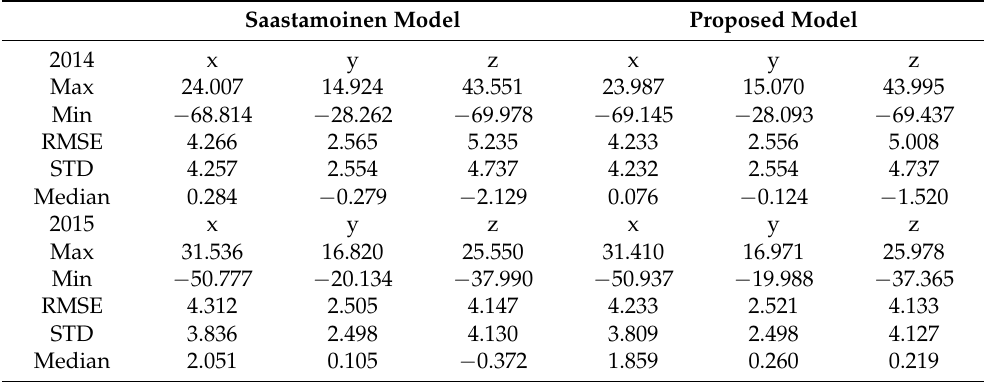
Table 6. Comparison of the achieved values of RMSE, STD, minimum, maximum, and median values for the Zadar GNSS position obtained using the Saastamoinen model and the proposed model (in m). Saastamoinen Model Proposed Model